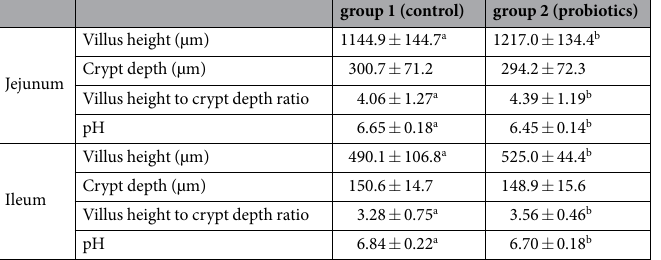
Table 2. Small intestinal morphology and pH of digestive tract contents (mean ± SD). a,b Different letters within rows indicate differences between treatment groups ( p < 0.05).